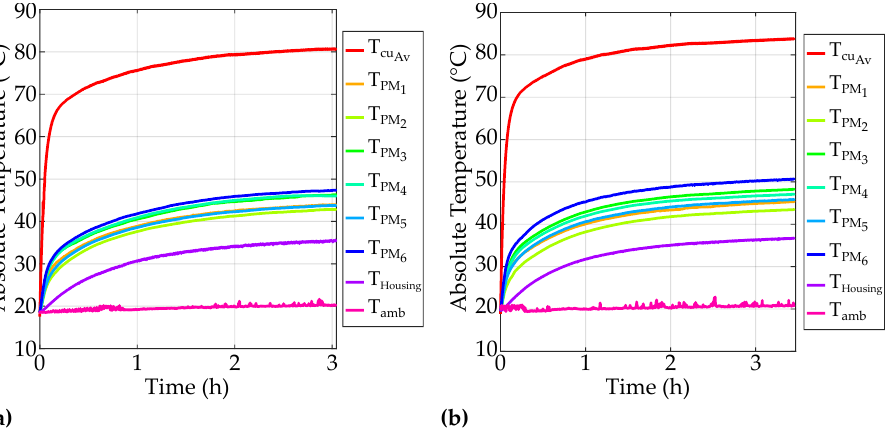
Figure 11. Results of the thermal tests of the LSFPM. ( a ) Horizontal at 20 W. ( b ) Vertical at 21